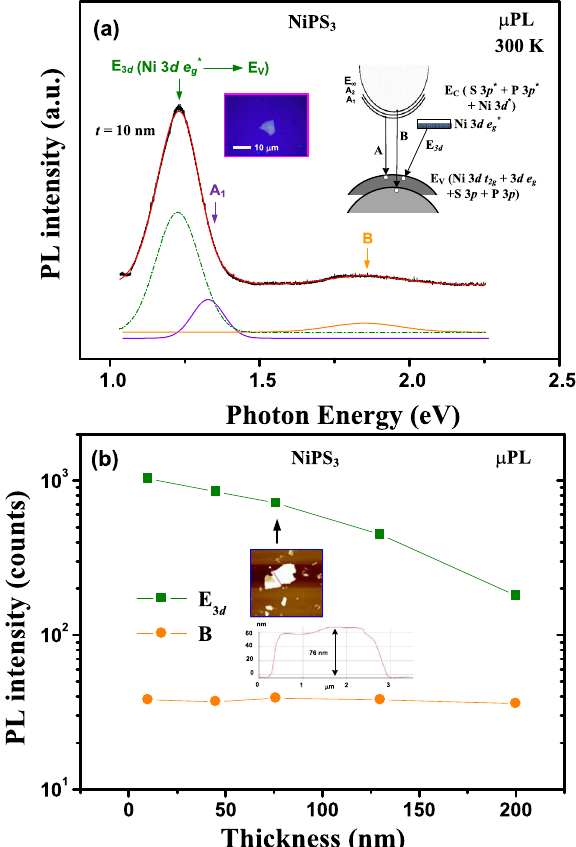
Fig. 5 Thickness-dependent μ PL result of few-layer NiPS 3 at 300 K. a μ PL spectrum of the band-edge emissions of a few-layer NiPS 3 sample with a thickness of ~10 nm at 300 K. The fi tting curves of the PL peaks are also included. The left inset shows a microscopic image of the few-layer sample, and the right inset shows the possible band-edge scheme for the observed PL emissions. b Thickness dependence of the PL intensities of the E 3d and B peaks detected in a